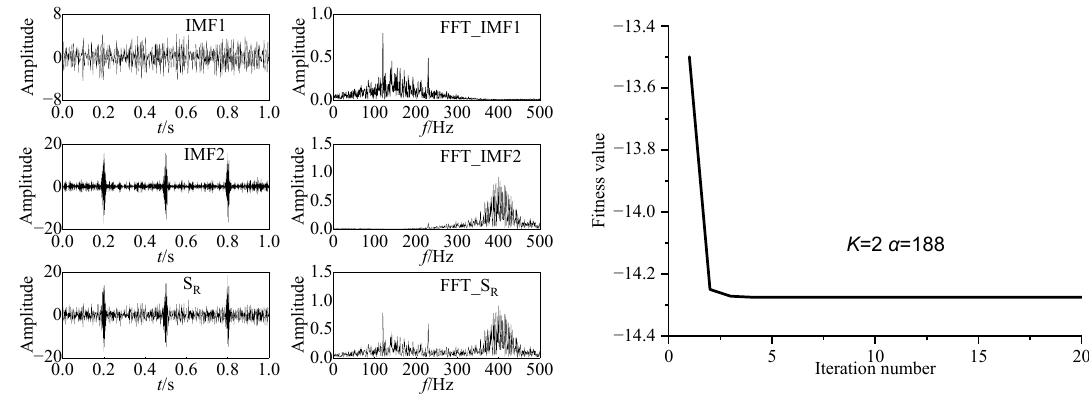
Figure 3. Decomposition results using optimized VMD with correlation kurtosis.